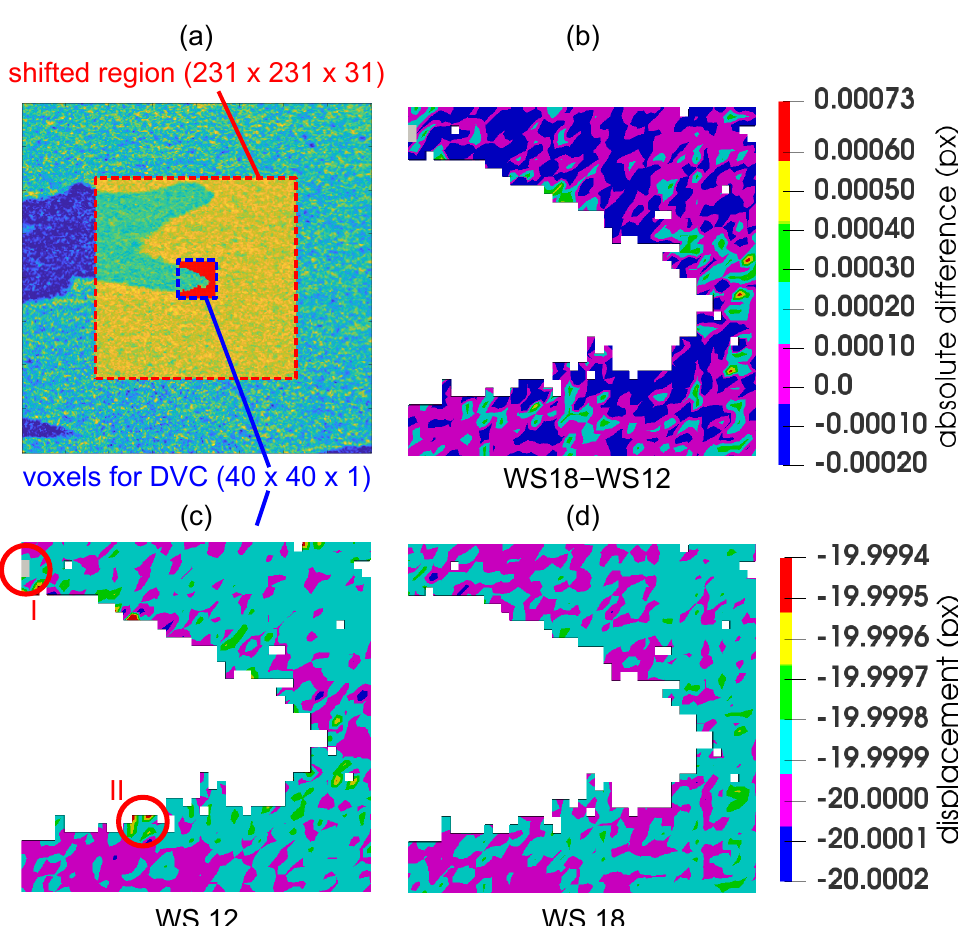
Figure 7. Determination the of optimal correlation window size: ( a ) red box-the dataset subjected to the in-plane numerical rigid body motion, blue box-the region, where the displacement was evaluated using the DVC, ( c , d ) the vertical displacement fields calculated using a correlation window size of 12 px and 18px, and ( b ) the difference field calculated using the results of the two correlation windows. The circular regions “I” and “II” depict the unconverged solution in grey and highest error in this sub-volume,